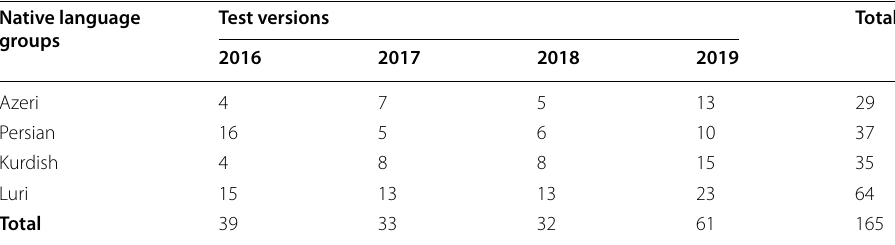
Table 15 Number of UDIF cases favoring each group in each test version Native language